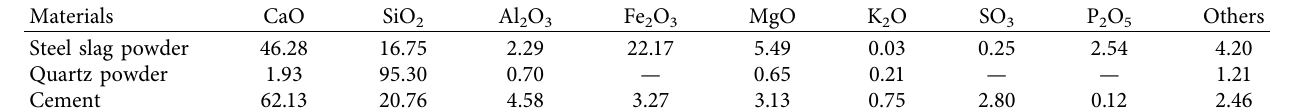
Table 1: Chemical compositions of steel slag and cement